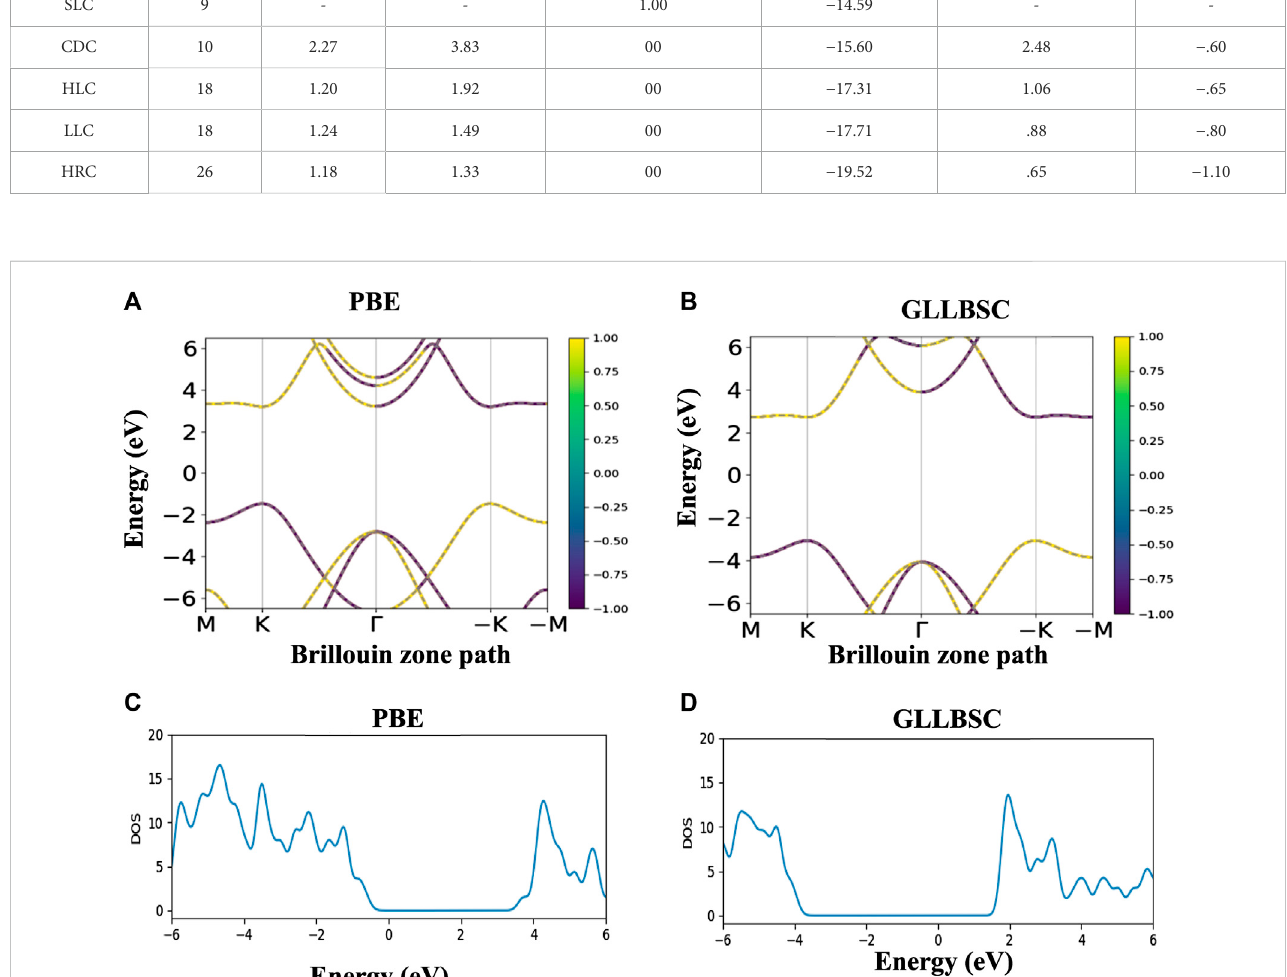
FIGURE 4 Ground state electronic structure in the pristine monolayer hexagonal boron nitride under the effect of spin orbit coupling showing the band structure (top panels) and the corresponding electronic density of states (bottom panels) calculated from PBE (A, C) and GLLBSC (B, D) functionals in the absence of carbonspecies.Thebandstructuresshowareversalofthechargepseudospindegreeoffreedomatthetimereversalsymmetric K and K ’ pointsoftheBrillouin zone because of the broken time reversal symmetry of the electron